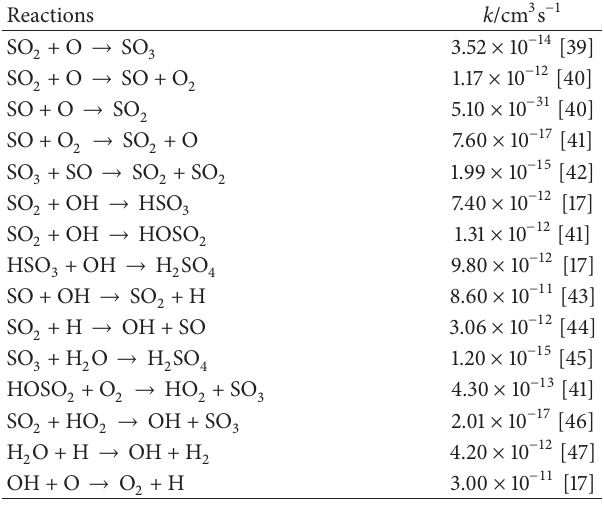
Table 1: Main reactions and the corresponding rate